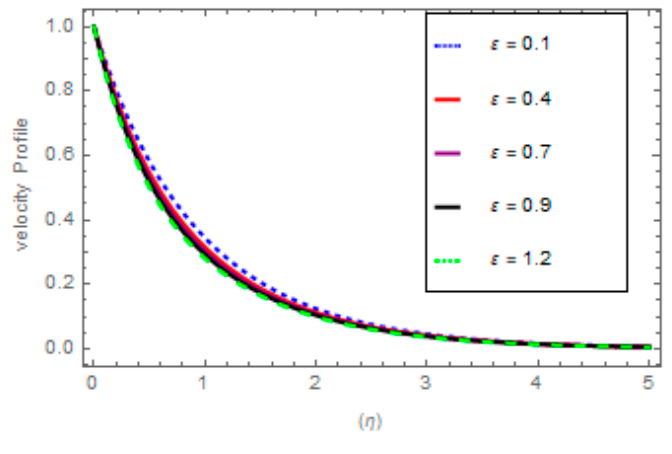
( ) ( ) ( ) ε ε ' ' ( η ) . ε u η . ' u η . u η . on on 0 on 0 0 0